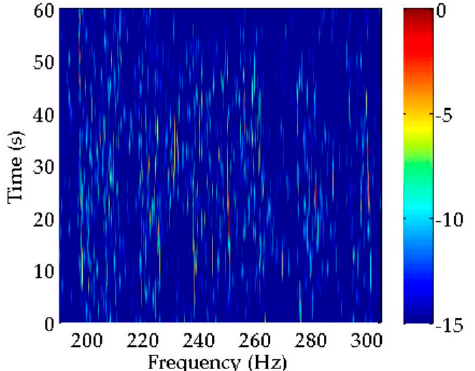
Figure 9. Spectral estimation result obtained by a periodogram.